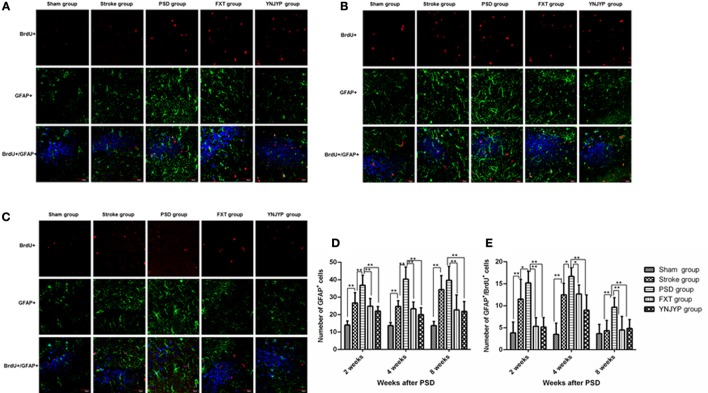
Effects of treatments on differentiation of newly formed cells toward astrocytes in PSD rats at 2, 4, and 8 weeks post-stroke. To observe the differentiation of newly formed cells toward astrocytes, newly formed cells were labeled with BrdU (red) and astrocytes were labeled with GFAP (green) at 2, 4, and 8 weeks. Cell nuclei were labeled with 4′,6-diamidino-2-phenylindole (blue). (A) At 2 weeks post-stroke. (B) At 4 weeks post-stroke. (C) At 8 weeks post-stroke. Scale bar = 30 μm. (D) The number of GFAP-positive cells at the observed dentate gyrus zone at 2, 4, and 8 weeks (at 2 weeks: F = 20.579, P < 0.001; at 4 weeks: F = 31.673, P < 0.001, at 8 weeks: F = 13.733, P < 0.001). (E) The number of cells double-positive for GFAP and BrdU at the observed dentate gyrus zone (at 2 weeks: F = 17.182, P < 0.001; at 4 weeks: F = 22.852, P < 0.001; at 8 weeks: F = 6.274, P = 0.001). n = 6; *P < 0.05, *P < 0.01. BrdU, 5-bromo-2-deoxyuridine; PSD, post-stroke depression; FXT, fluoxetine hydrochloride capsules; YNJYP, Yi-nao-jie-yu prescription.